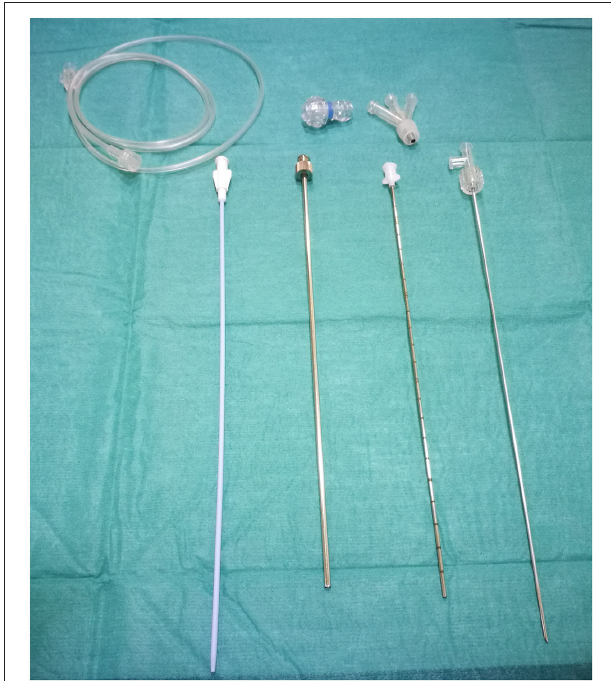
FIGURE 2 | MicroPerc system set.